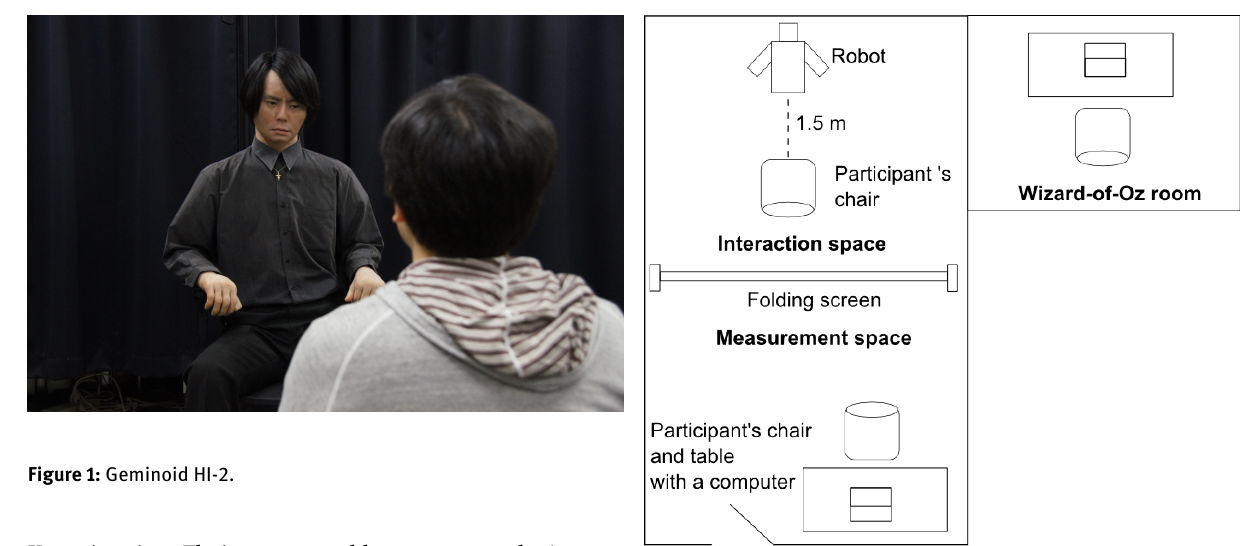
Kansai region. Their age ranged between 18 and 36 years with a mean age of 21.5.